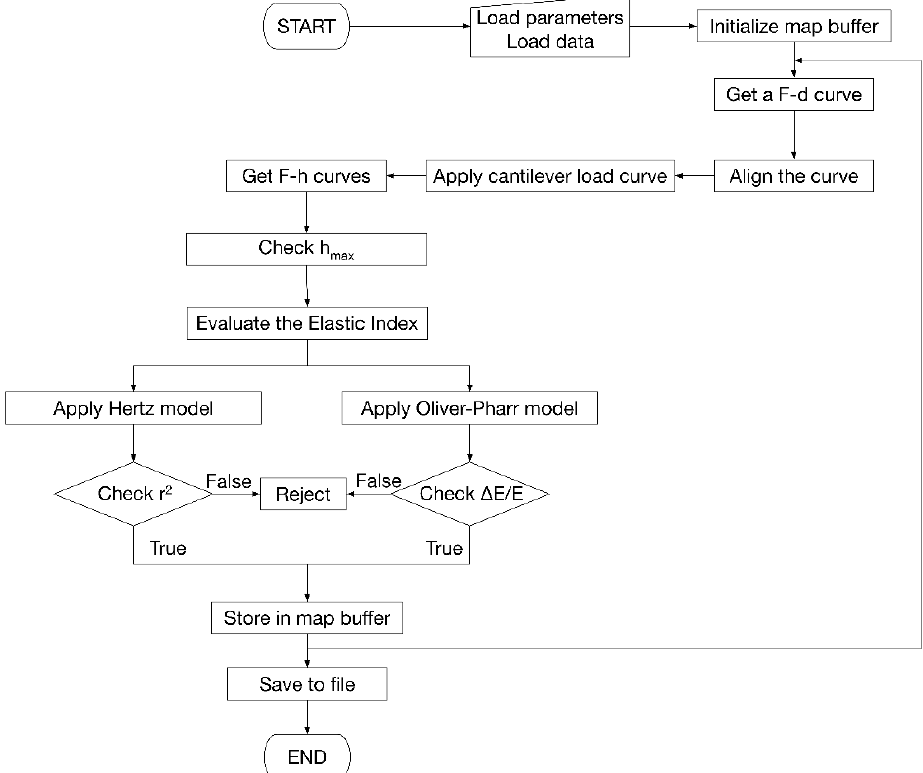
Figure 2. Flowchart of the algorithm developed for the evaluation of Young’s modules, including model selection criteria and map construction.